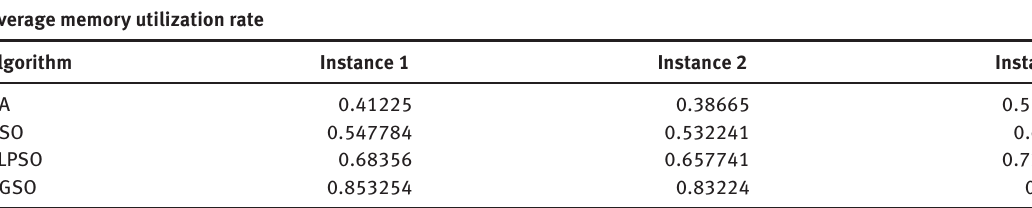
Table 15: Comparison for Memory Utilization Rate.